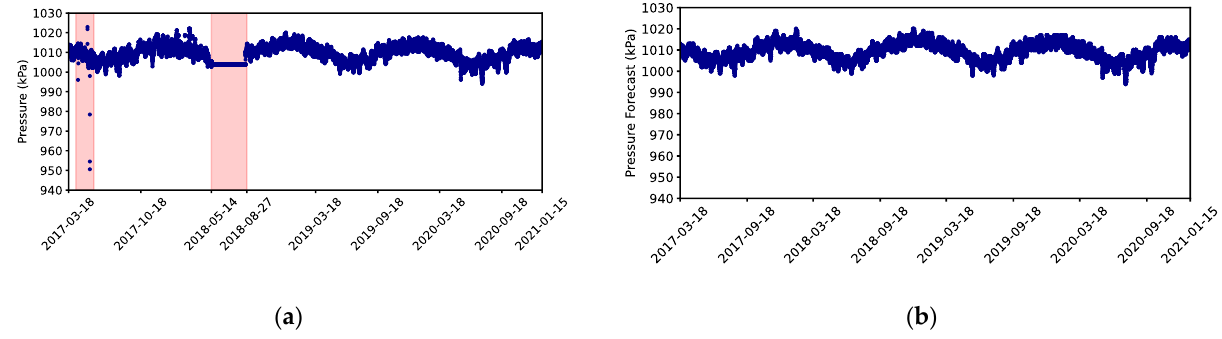
Figure 2. Air pressure curves of “IEEE DataPort Competition Day-Ahead Electricity Demand Fore- casting: Post-COVID Paradigm”. ( a ) measured air pressure values, highlighting the regions with discrepant values, shown by the hatched areas in light red; ( b ) air pressure values obtained from the weather forecast.